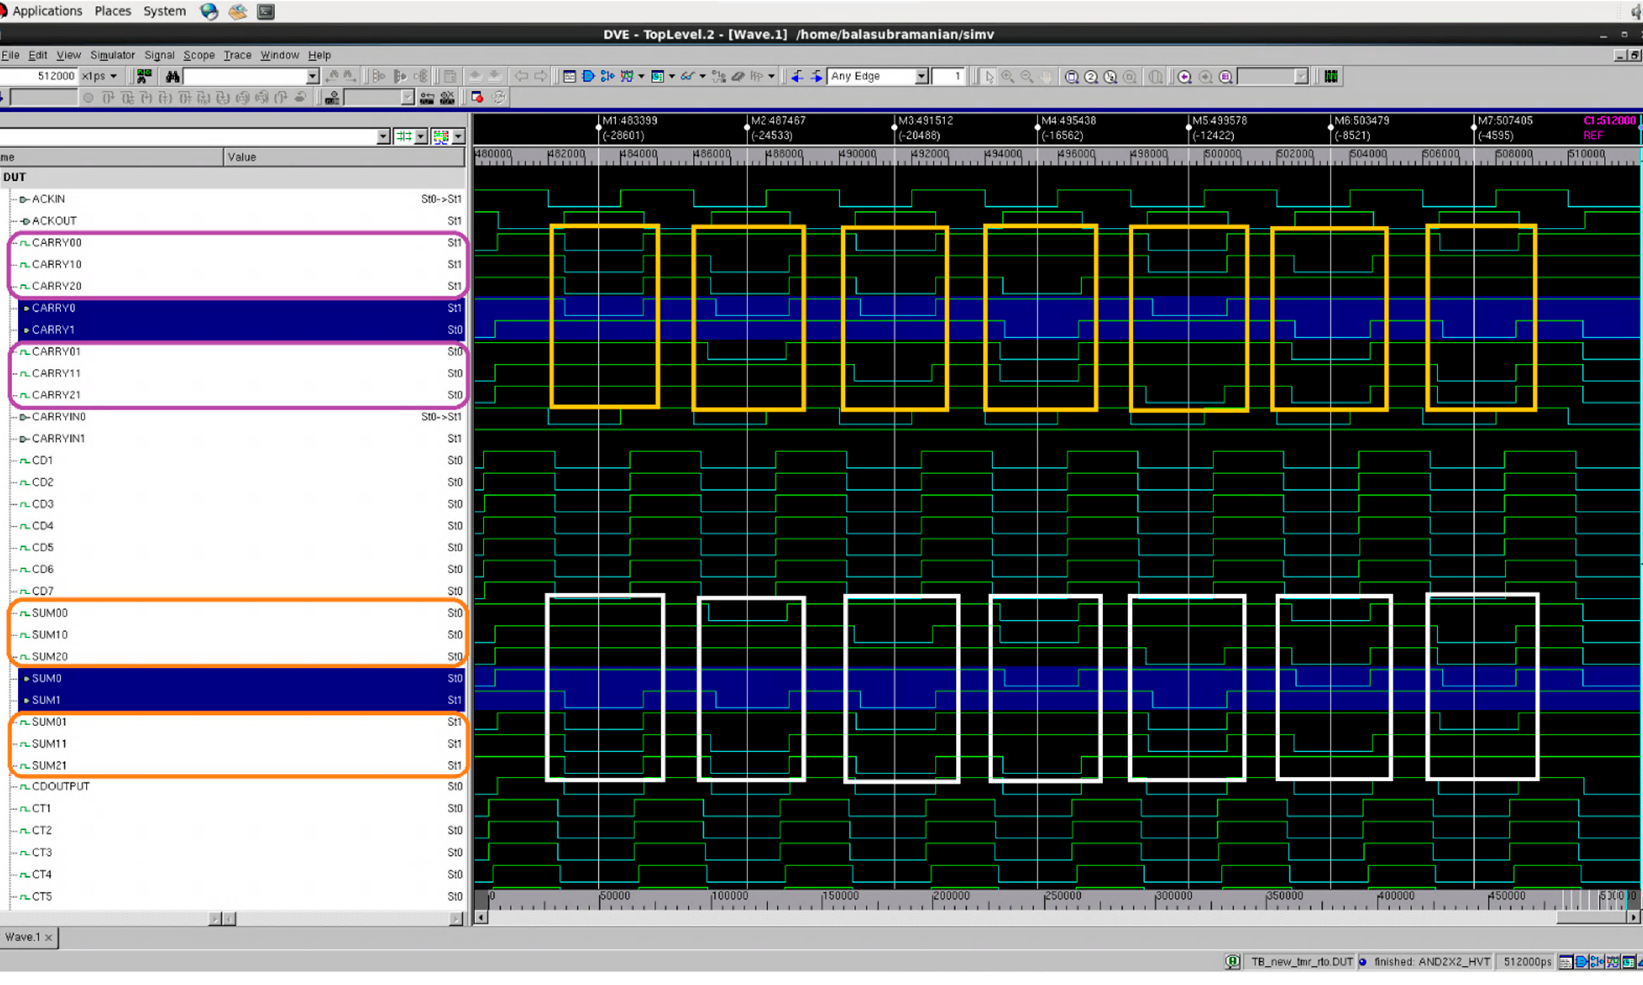
Figure 6. Screenshot of a portion of simulation waveforms of the TMR implementation incorporating the proposed majority voter (NEO_MV) corresponding to RTOH. Binary 0 represents data in the case of RTZH. Majority voted sum output (SUM1,SUM0) is captured within the white rectangles and majority voted carry output (CARRY1,CARRY0) is captured within the yellow rectangles.